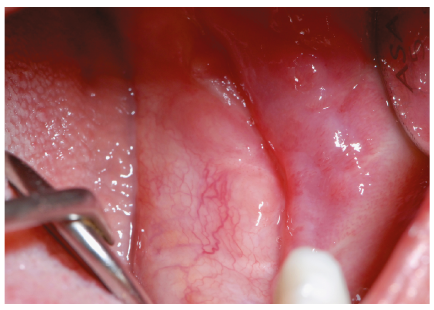
Figure 4: One-year